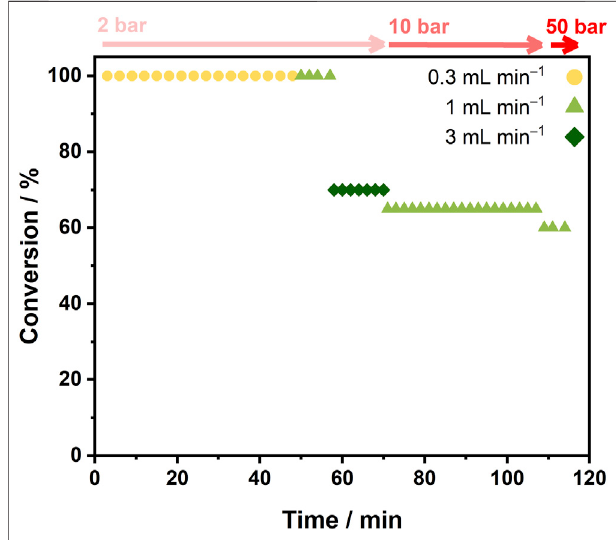
FIGURE 5 | Continuous conversion of NAD + to NADH using SH/C [SH (1.6 mg), activated charcoal (30 mg)] in the hydrogenation fl ow reactor over time under different liquid fl ow rates and pressures (top axis). Reaction conditions: NAD + (1 mM), Tris-HCl buffer (50 mM, pH 8.0), liquid fl ow rate (cid:1) 0.3, 1 or 3 ml min − 1 , H 2 fl ow rate ≈ 12 ml min − 1 , t Res (cid:1) 0.8, 0.9 or 1.0 s, reactor volume (cid:1) 0.2